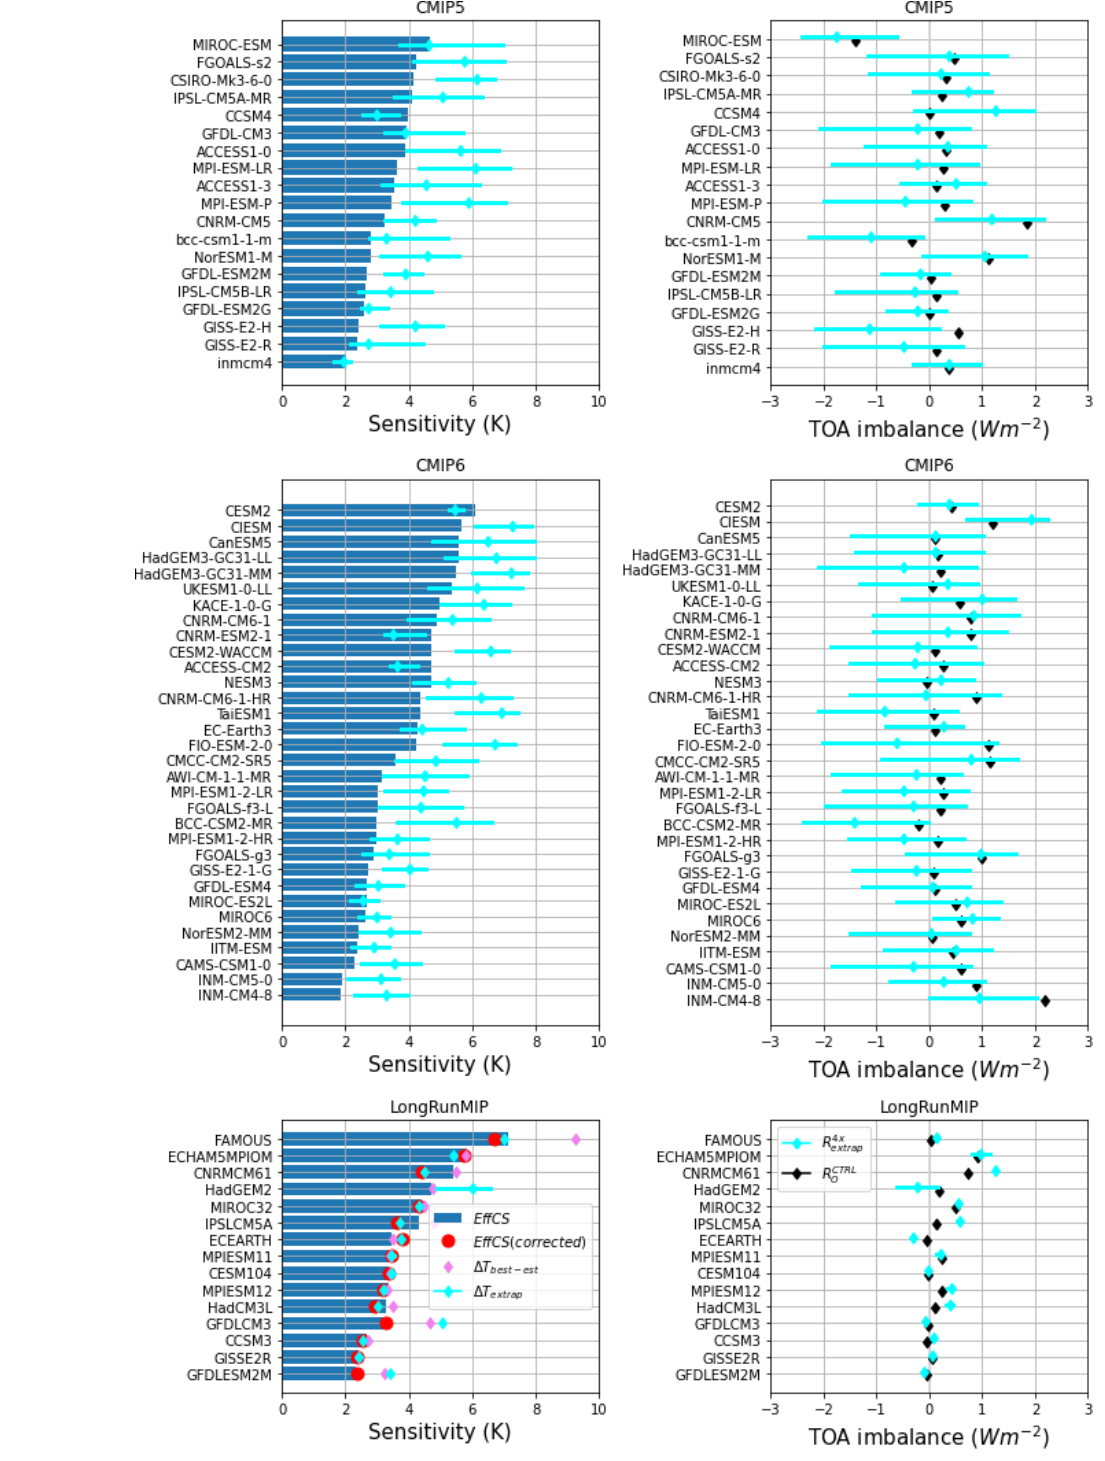
Figure 5. Bar plots summarizing results for three model ensembles, CMIP5 (top row), CMIP6 (middle row) and LongRunMIP (bottom row). Left-hand column shows different estimates of equilibrium climate sensitivity. Solid blue bars show EffCS (see text). Light blue diamond and whiskers show the median, 5th and 95th percentiles of (cid:49)T extrap . For LongRunMIP, (cid:49)T best − est (following Rugenstein et al., 2020), is shown in violet diamonds, while EffCS corr is shown with red circles. The right-hand column shows R 4 x extrap (light blue diamond and whiskers) and R CTRL (black 0